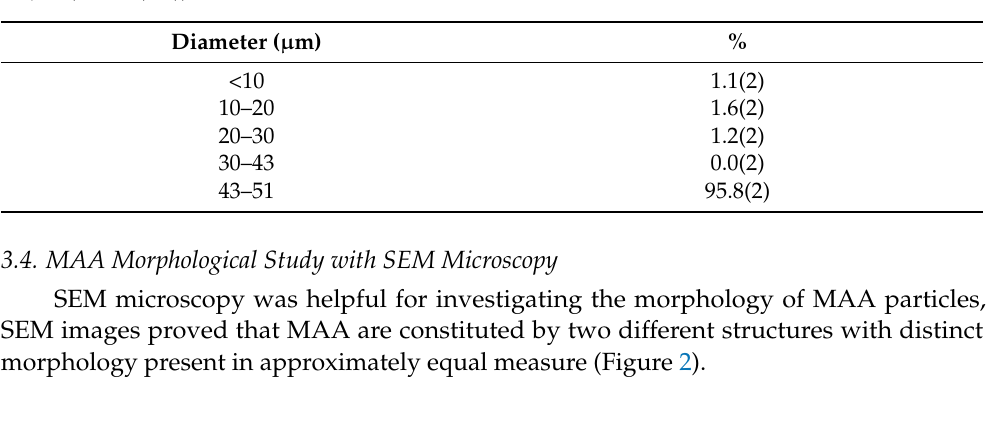
Table 2. Size distribution showed a high percentage of particles with a dimension between 43 and 51 µ m (Mean (SD)).